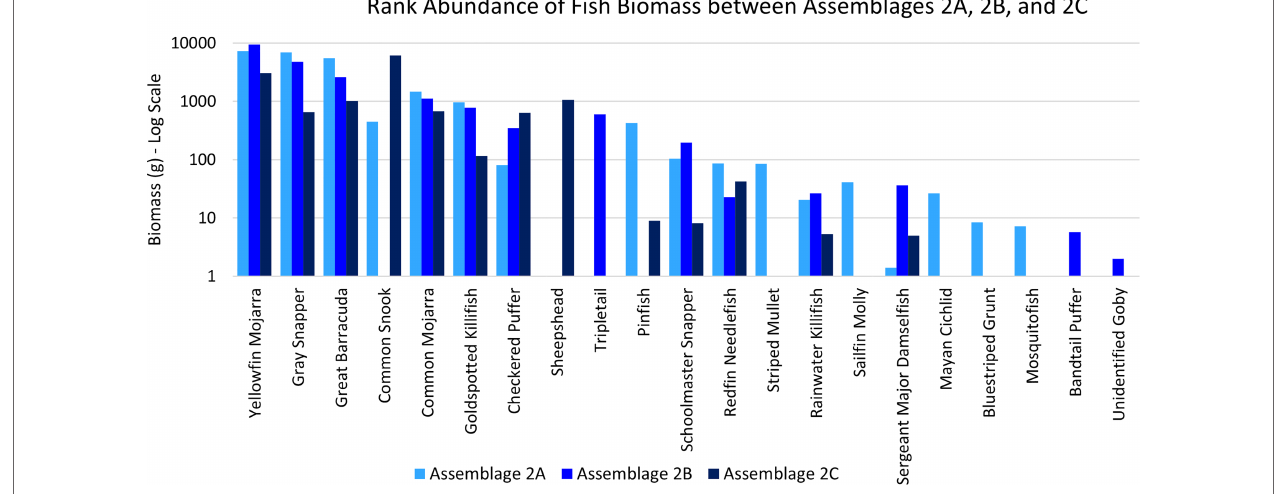
FIGURE 8 | Ranked biomass of fish species found in Assemblages 2A, 2B, and 2C. The biomasses are averaged by the number of sites forming each assemblage and shown on a log scale.